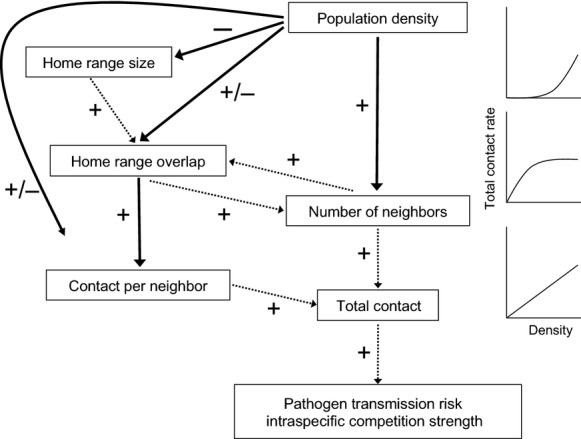
Possible pathways through which increases in density might influence contact rates, leading to accelerating, saturating, or linear relationships between density and contact rates. Solid lines indicate hypothesized pathways tested in this study. Dashed lines indicate pathways not directly addressed in this study.